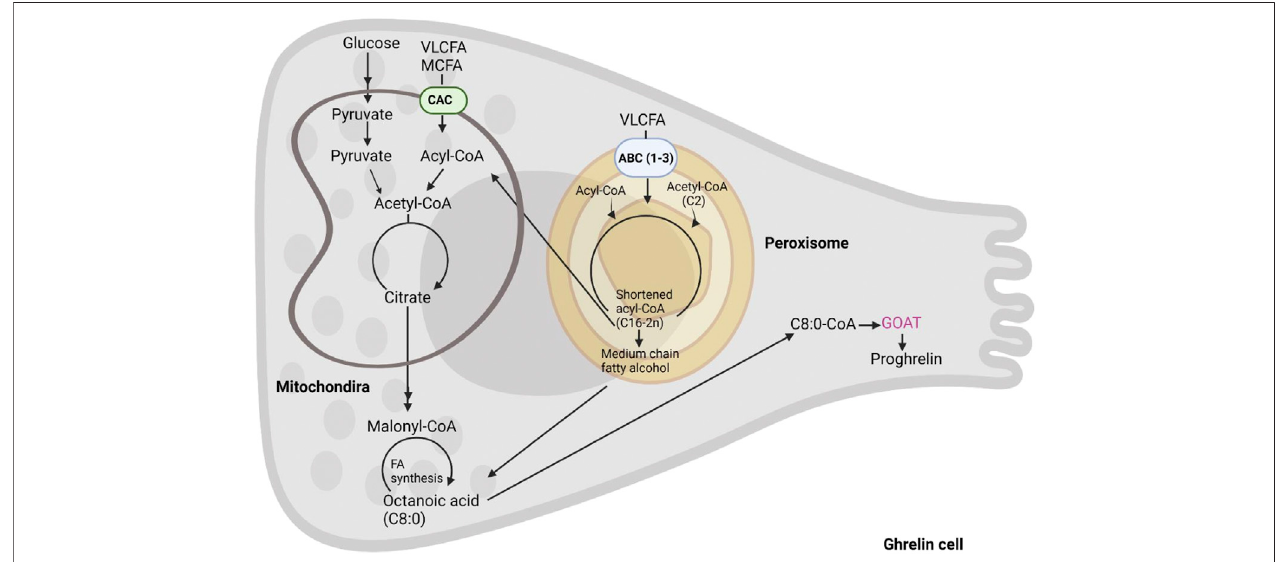
FIGURE 4 | The formation of octanoic acid in the enteroendocrine cell. Acyl-ghrelin is predominantly bound by C8:0. In this schematic we summarize the intracellular C8:0 forming pathways including, fatty acids from diet, fatty acid synthesis and beta-oxidation of long chain fatty acids.